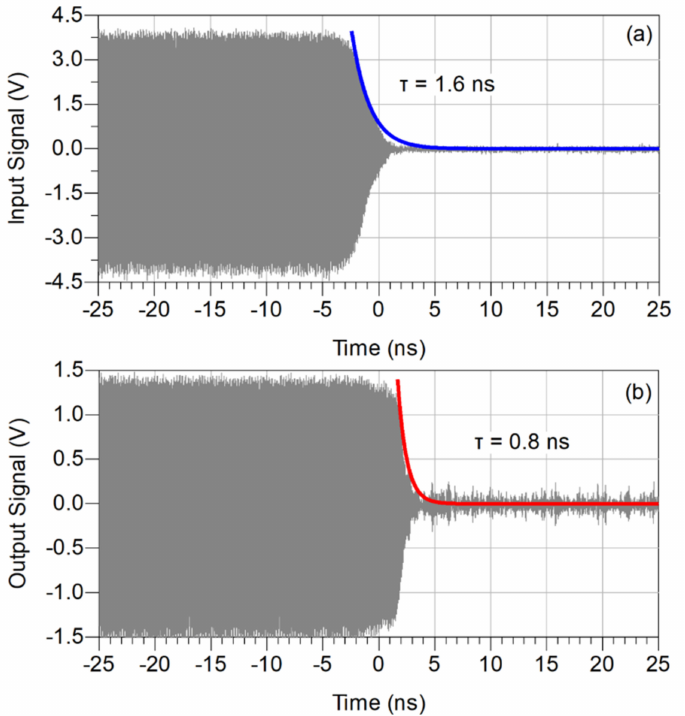
Figure 8. Approximation of the signal edges with an exponential function. ( a ) Input signal; ( b ) output